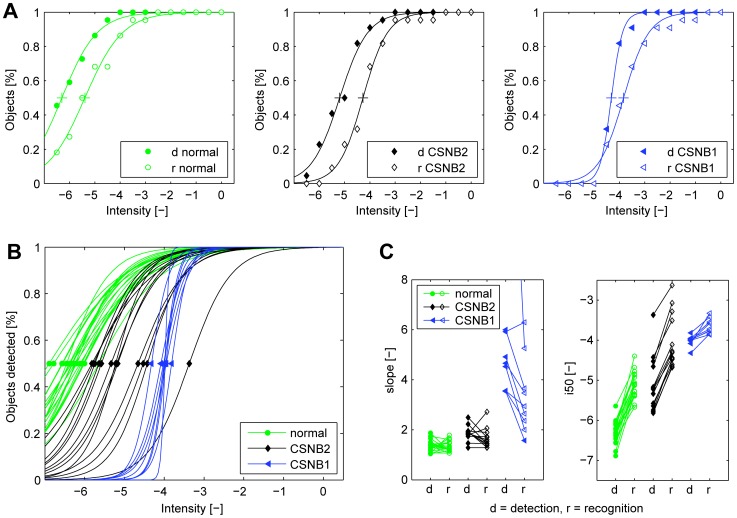
2D Light Lab results of the normal subjects, the CSNB2 patients, and the CSNB1 patients.
A: Three representative examples of the results from the 2D Light Lab. The figure shows the cumulative of the relative number of objects detected or recognized, the fit of the psychometric curve, and the crossmarks that indicate the intensity at which 50% of the objects were detected or recognized (i50d and i50r). B: The psychometric fit to the cumulative of objects detected at increasing light levels in the 2D Light Lab for each subject. The green dots (control subjects), black diamond (CSNB2 patients) and blue triangles (CSNB1 patients) in each fit indicate i50d and i50r. C: The parameters (slope, left) and (i50, right) of the psychometric fit to the 2D Light Lab results of all subjects. Overall we found equal slopes for detection and recognition in control subjects and in CSNB2. However, in the CSNB2 patients the curves were shifted toward higher intensities. The two curves of the CSNB1 patients were steeper, closer together and shifted towards higher intensities compared to control subjects.